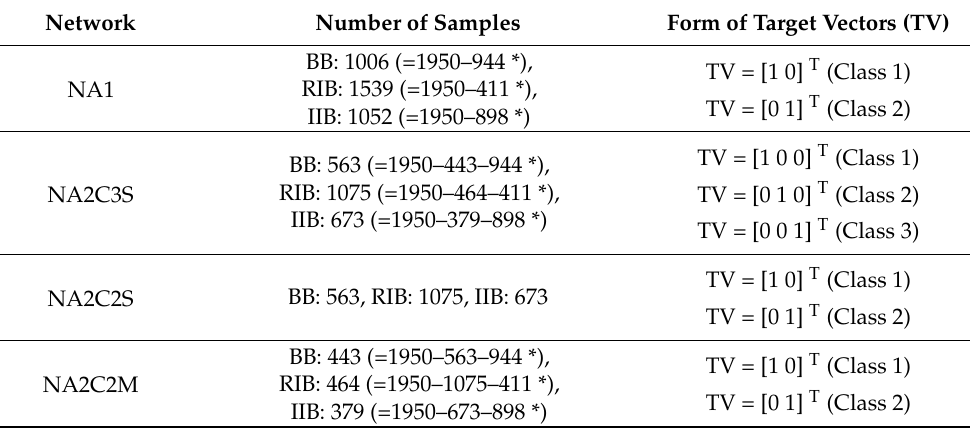
Table 4. Number of samples and the form of target vectors for each of the networks and the versions of the selected RC